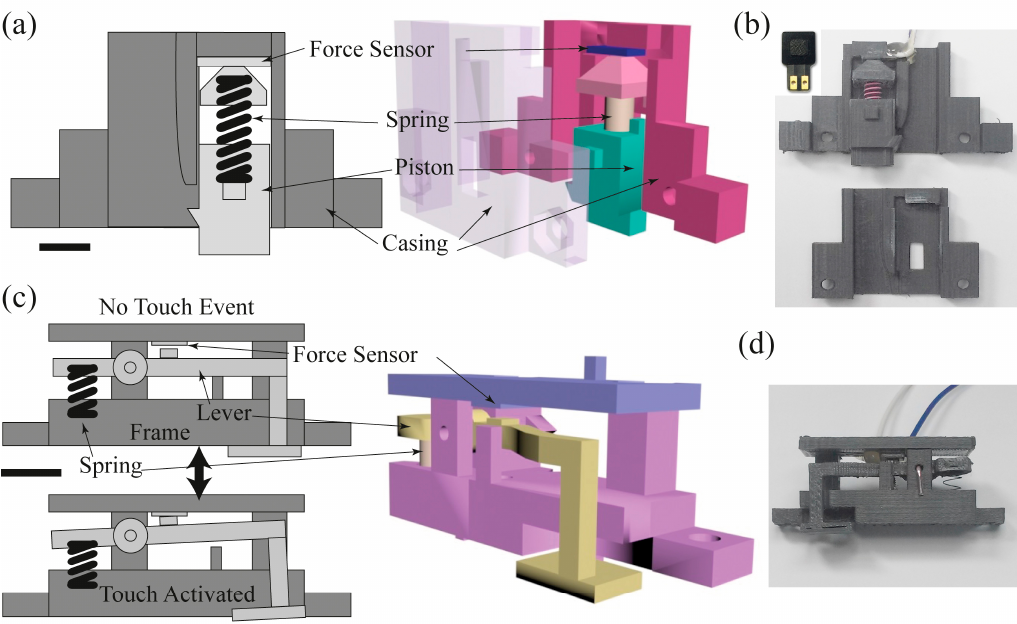
Figure 3. Design and assembly of the stiffness measurement system. ( a ) Cross-sectional schematic of the f-module, and ( b ) a picture of fabricated f-module parts. Inset shows a picture of the force sensor. ( c ) Cross-sectional schematic of the t-module, and ( d ) a picture of an assembled t-module. The scale bars in ( a , c ) represents 1 cm.